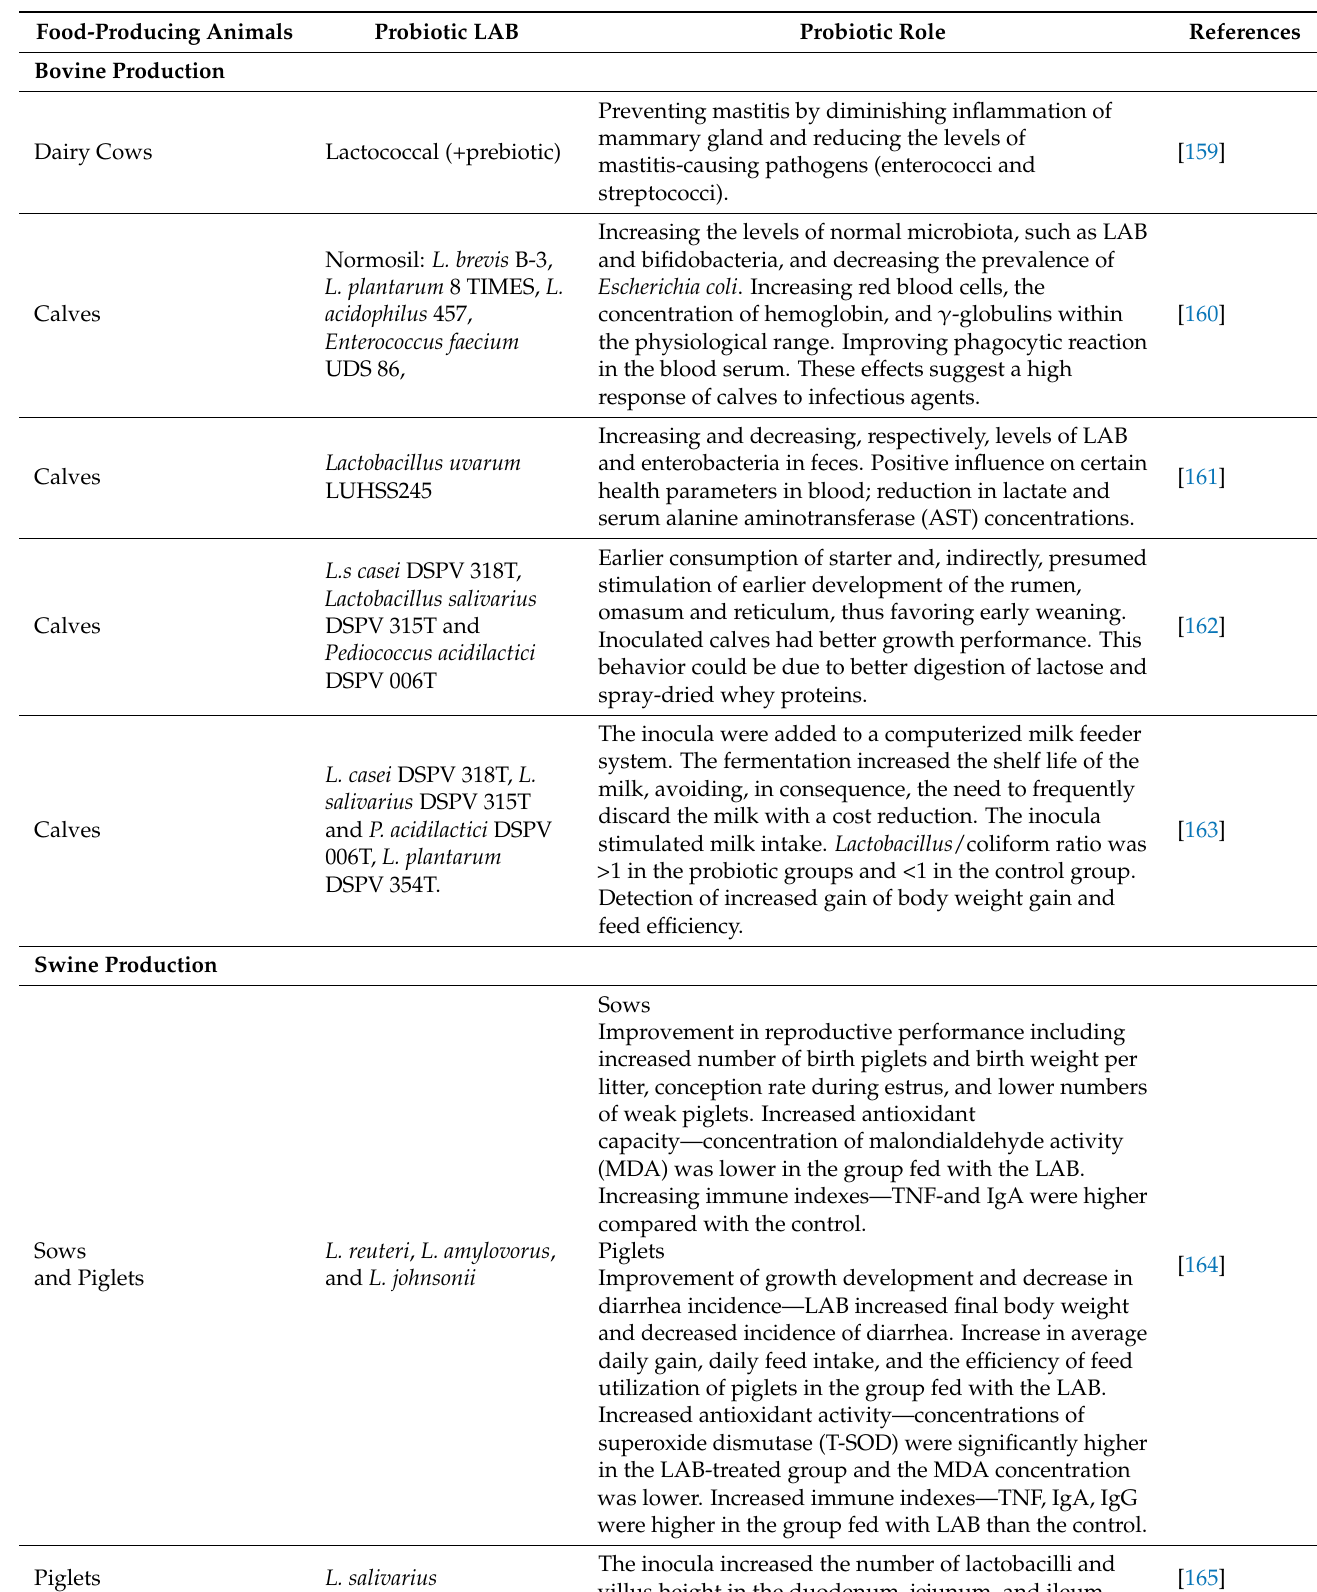
Table 1. Examples of use of LAB and their applications on